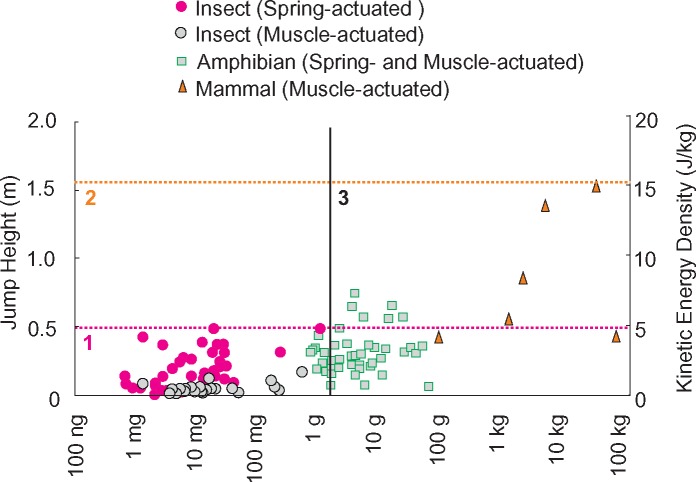
Jump heights and energy densities of the whole system for 142 species. Spring-actuated jumping insects are shown with gray circles with a black circumference, muscle-actuated insects are shown with filled magenta circles. Amphibians are shown in green squares (these use a combination of spring-actuated and muscle-actuated systems). Muscle-actuated jumping mammals are shown with orange triangles with black edges. Magenta dashed line (1): the jump height limit for purely spring-driven systems, estimated as 28% of the available muscle energy, as predicted by the simulations in Fig. 1. Orange dashed line (2): the jump height limit for purely muscle-actuated systems, estimated as 100% of the available muscle energy, as predicted by the simulations in 1. The black vertical line (3) represents the predicted “crossover point” between spring and muscle actuated systems. Data are from Alexander (1974); Brackenbury and Wang (1995); Burrows (2006); Burrows (2009, 2011, 2013, 2014); Burrows and Dorosenko (2015a, 2015b); Burrows et al. (2007); Burrows and Morris (2002, 2003); Burrows and Wolf (2002); Burrows and Dorosenko (2014); Evans (1972); Burrows and Picker (2010); Patek et al. (2006); Picker et al. (2012); Schwaner et al. (2018); Sutton and Burrows (2011); and Moen et al. (2013).